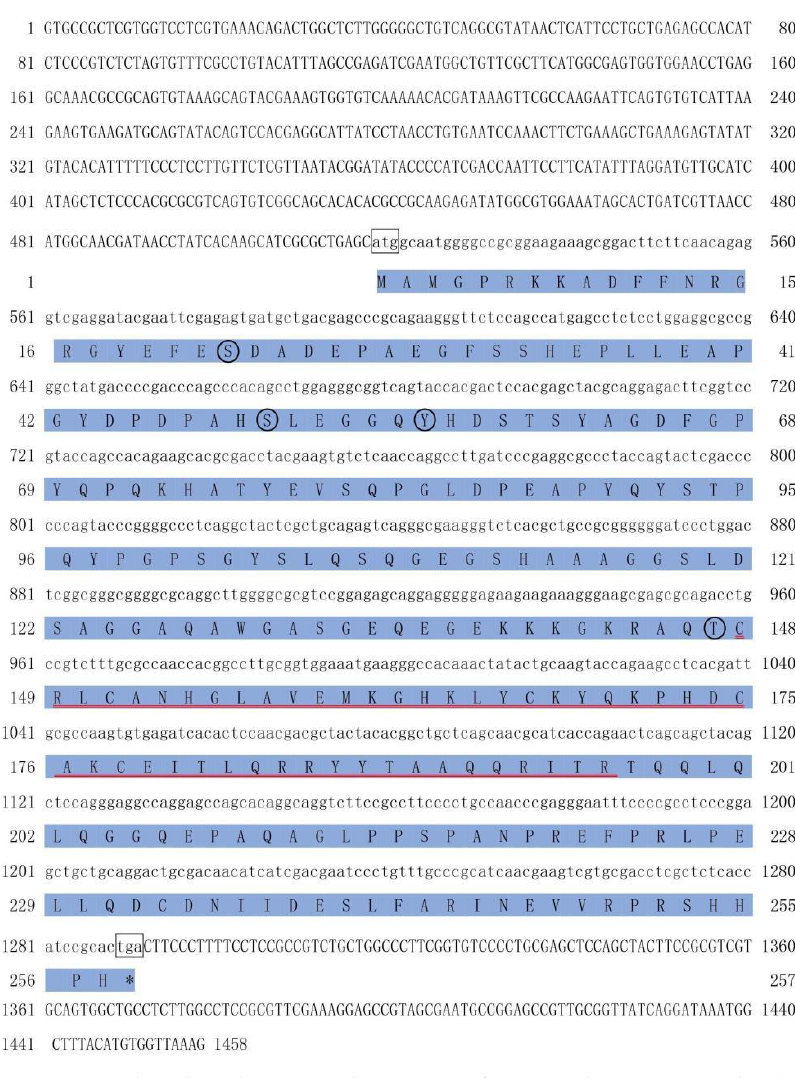
Figure 1. Nucleotide and amino acid sequences of PmDsx . The initiation codon (ATG) and a termina- tion codon (TAA) are boxed in black, the (ORF) is shaded in blue, the DM domain is underlined by the red line, and the phosphorylation sites are circled in black.